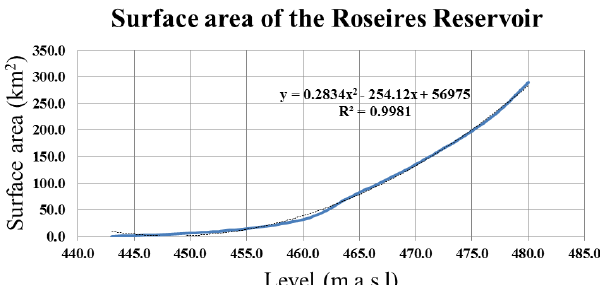
Figure 5. Water surface area in Roseires Reservoir as a function Fig. 5. Water surface area inRoseires Reservoir as a function of elevation (Irrigation of elevation (irrigation datum). The dotted line represents the trend Datum). The dotted line represents the trend line used in the study. line used in the